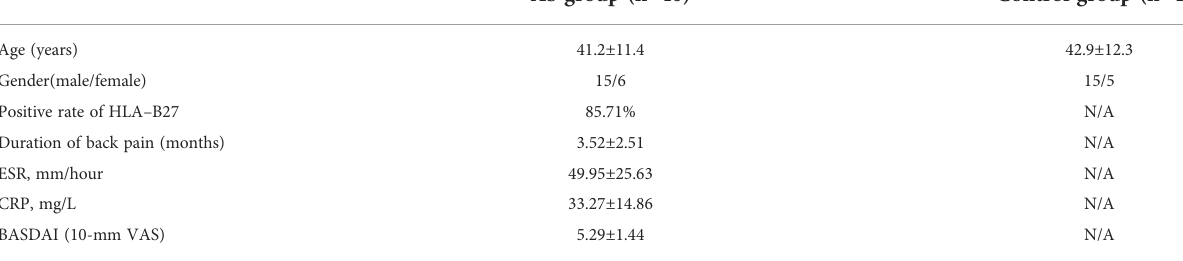
TABLE 1 General information of the AS patients and control